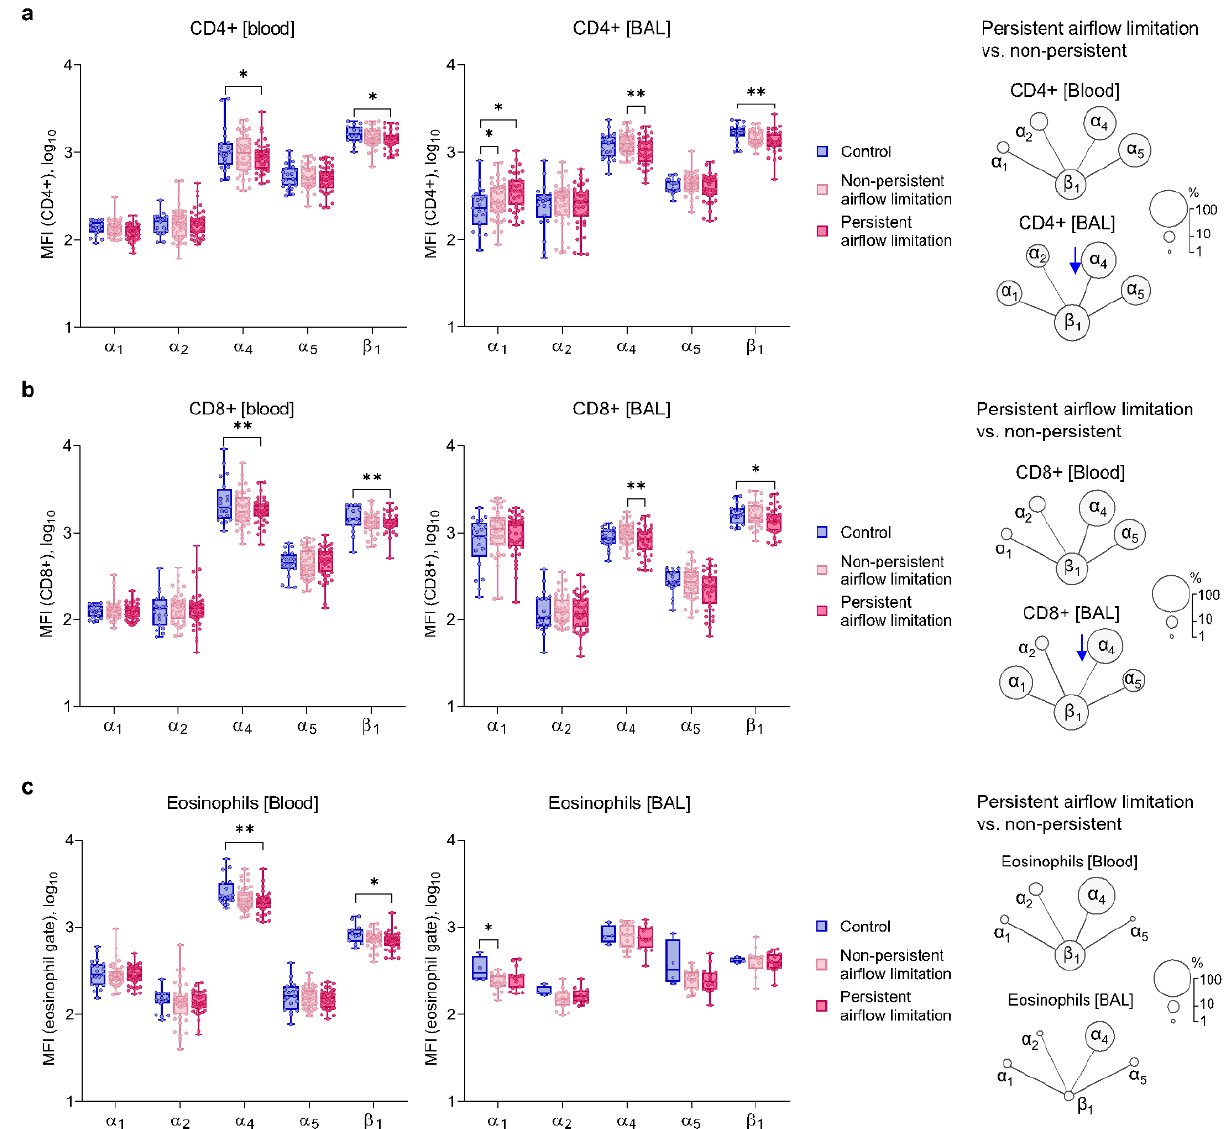
Figure 2. Surface expression (median fluorescence intensity [MFI]) of integrin chains on T-cells and eosinophils in asthma patients with persistent vs. non-persistent airflow limitation and controls. ( a , b ) Patients with persistent airflow limitation showed lower expression of α 4 and β 1 on both blood T-cell subsets, decreased β 1 on both BAL T-cell subsets, and increased α 1 on BAL CD4 + T-cells but only compared to controls. They also had lower α 4 on both BAL T-cell subsets comparing the non-persistent airflow limitation group (blue arrows in the diagram on the right). (c) Blood eosinophils of persistent airflow limitation patients had lower α 4 and β 1 than controls and no difference compared to the non-persistent airflow limitation subgroup. Data are presented as medians and range (T-cells: blood n = 108, BAL n = 101; eosinophils: blood n = 103, BAL n = 35; β 1 was measured in 78% of samples). Statistics: ANCOVA with adjustment for age, sex, and BMI: * p < 0.05, ** p < 0.01.